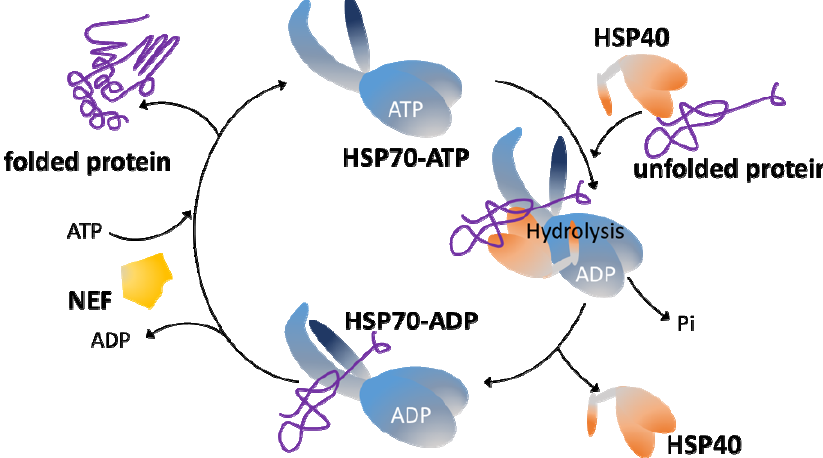
Figure 1. Overview of the HSP70/HSP40 chaperone system. An unfolded protein (the substrate) binds to an HSP40 member, and both form a complex with the HSP70 chaperone in its ATP-state, which has low affinity for polypeptides. The HSP40–HSP70 interaction triggers ATP hydrolysis and promotes a conformational change in the HSP70 (ADP-bound state) that results in a structure with high affinity for the protein substrate, which is bound into the substrate binding domain (SBD) of HSP70. Following substrate transfer, HSP40 leaves the complex, and the nucleotide exchange factor (NEF) is recruited to the HSP70–polypeptide complex, stimulating the ADP-by-ATP exchange. ATP binding induces both release of NEF and the folded polypeptide and leaves HSP70 ready for a new cycle.